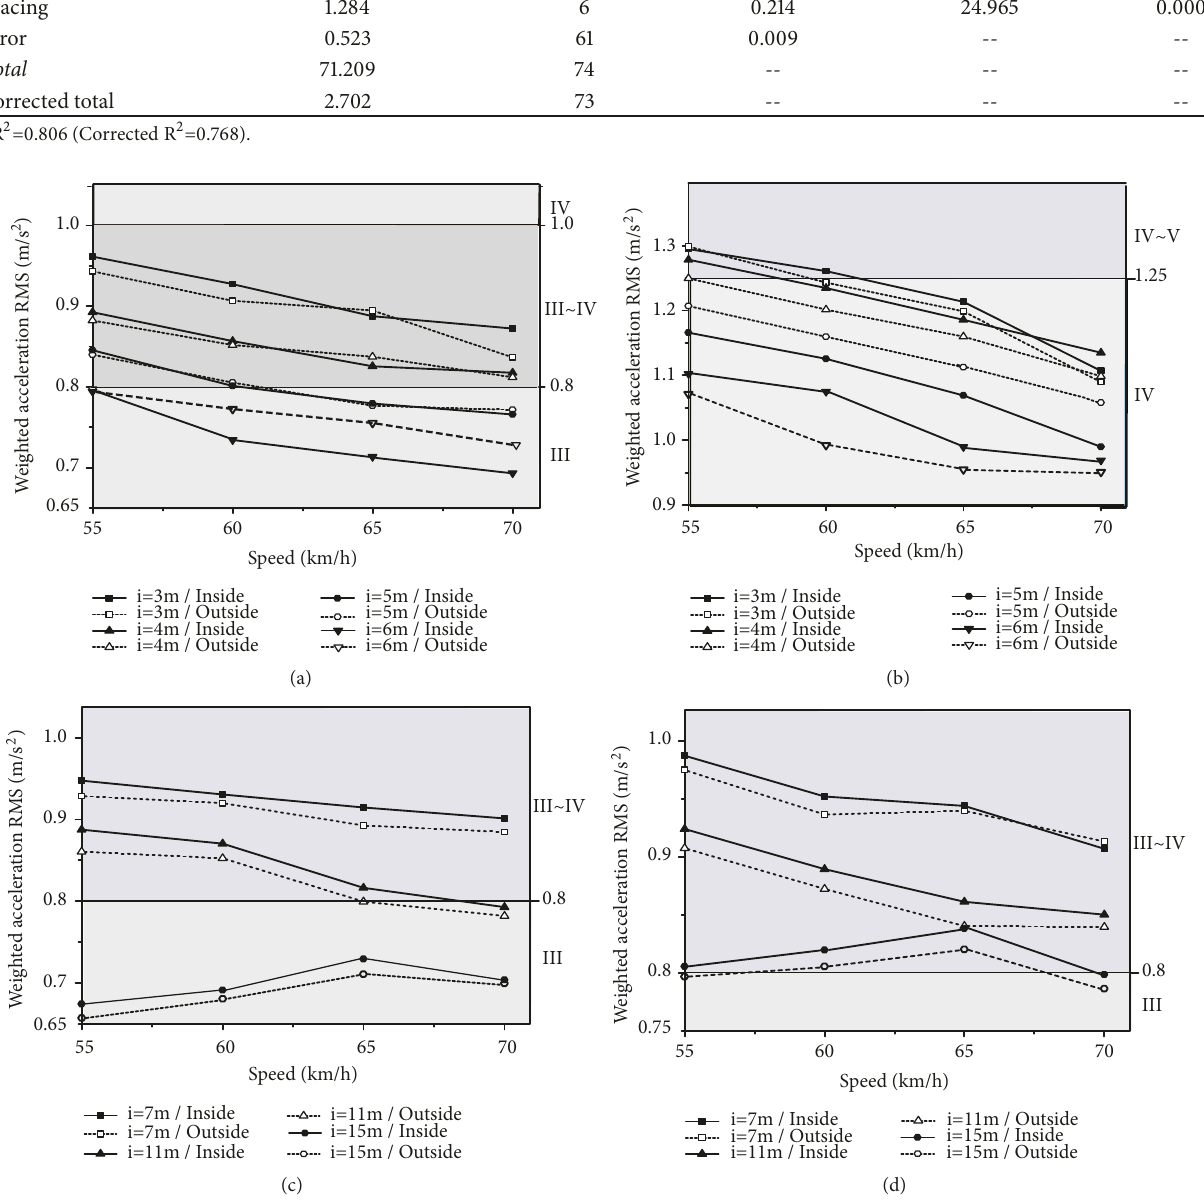
Figure 4: The combined total weighted acceleration RMS for the deceleration lane: (a) the linear deceleration lane (car); (b) the linear deceleration lane (semi-trailer truck); (c) the curved deceleration lane (car); (d) the curved deceleration lane (semi-trailer